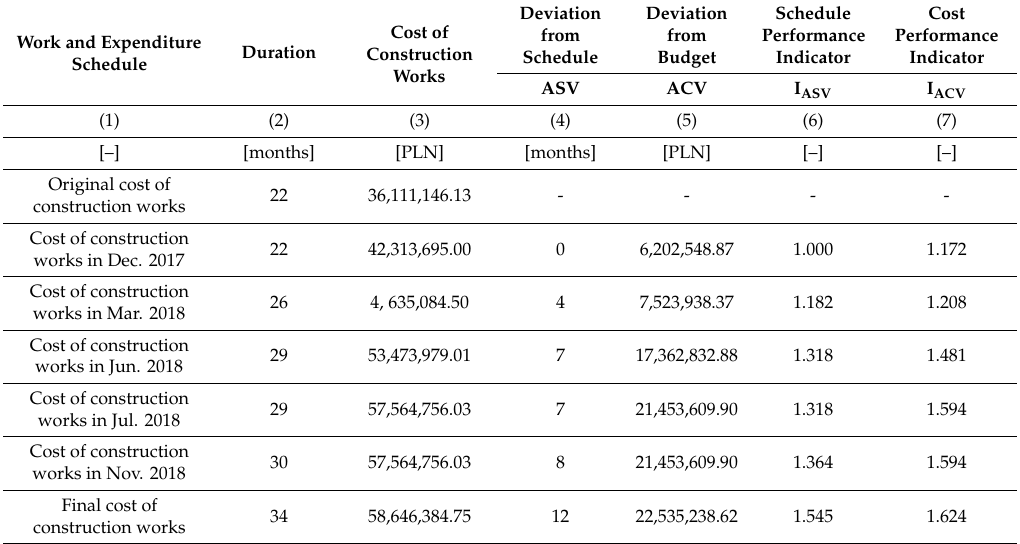
Table 2. Results of measurements and cost analyses of the assessed hotel facility (own